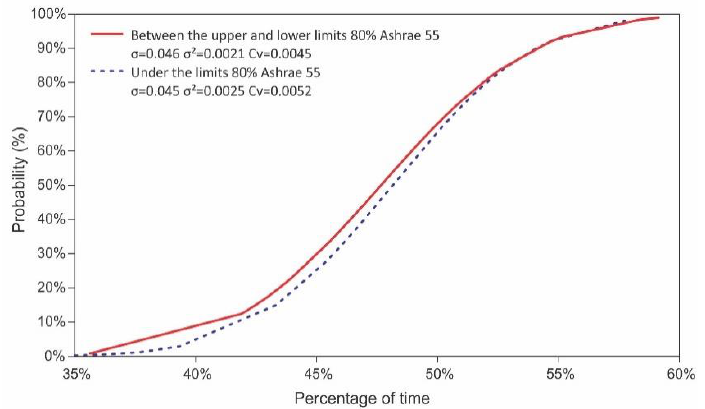
Figure 3. Accumulated probability distribution so that indoor temperatures of dwellings are between upper and lower comfort limit for a thermal acceptability of 80% of the ASHRAE 55:2017 adaptative thermal comfort model, and below the lower limit.